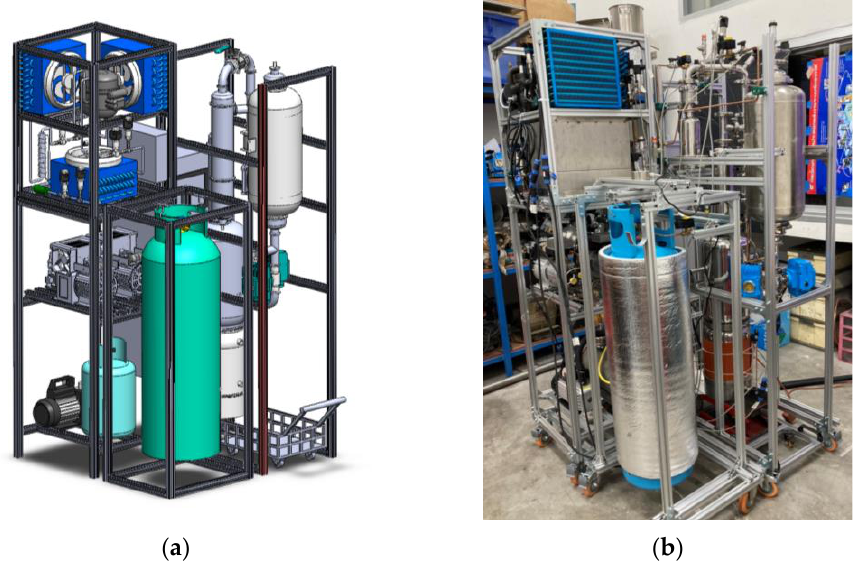
Figure 9. HFC-134a extractor: ( a ) CAD model; ( b ) as-built machine. Essential oil yield was calculated based on Equation (1), which depends on the ratio of the weight of essential oil from the extraction ( m oil ) and the initial weight of raw material before the extraction ( m raw ).